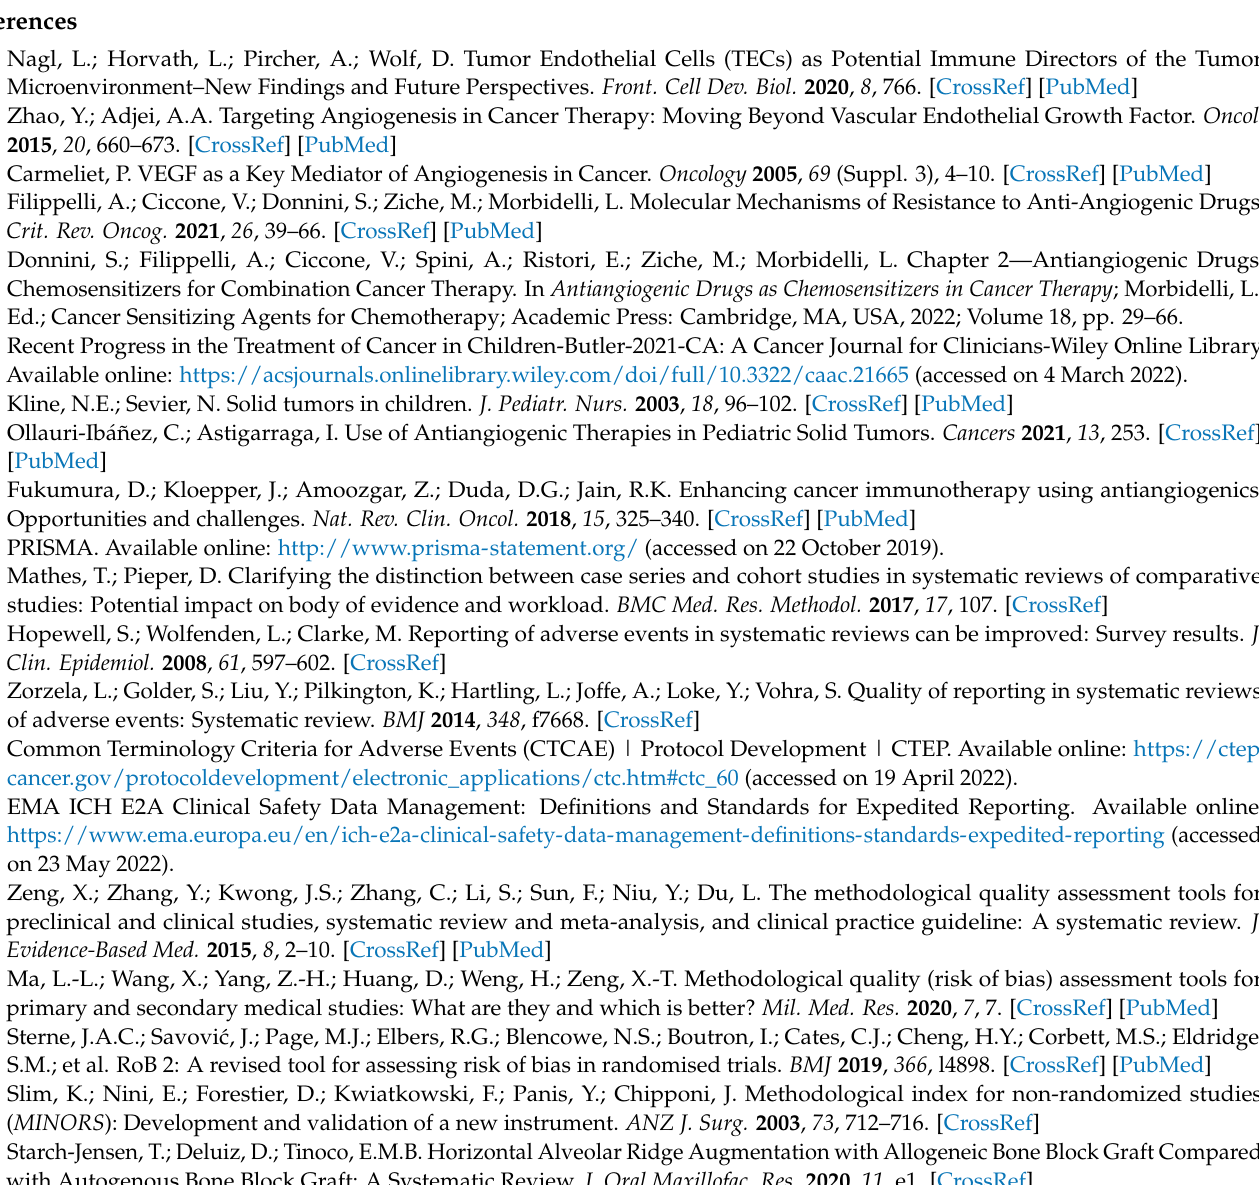
and Clinicaltrials.gov; Table S2: Characteristic of the safety population of the included studies, Table S3: Cochrane risk of bias tool assessment for randomized controlled studies, Table S4: MINORS tool